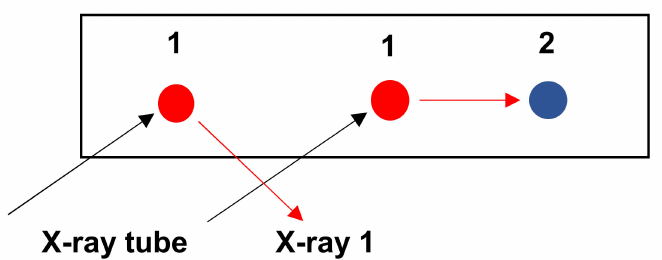
Figure 11. Fluorescence X-rays’ effects. The energy from atom 1 is weak and there is no excitation of atom 2 so the energy is absorbed without causing anything at the level of the electrons of atom 2.